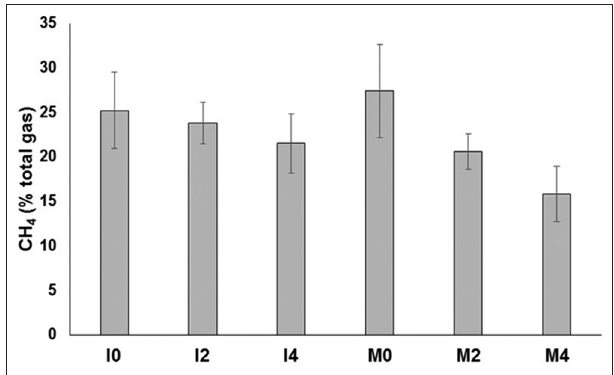
Figure-1: In vitro methane concentration (% total gas) of Indigofera and Moringa leaf silage with different level of chestnut tannin addition. I0, Indogofera leaf silage; I2, Indogofera+2% chestnut tannin; I4, Indogofera+4% chestnut tannin; M0, Moringa leaf silage; M2, Moringa+2% chestnut tannin; M4, Moringa+4% chestnut tannin. p: forage=0.282, tannin=0.027, forage×tannin=0.300. Error bar indicates standard error for each